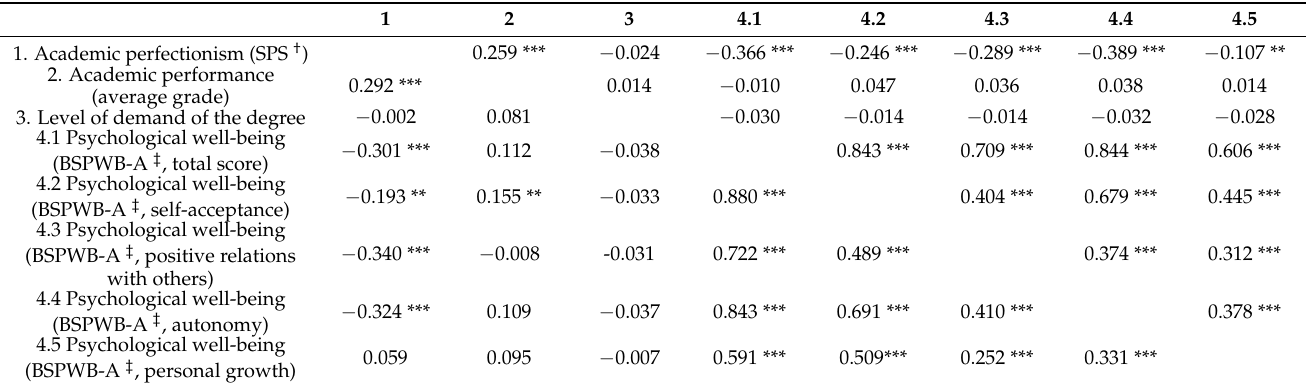
Table 1. Correlation between academic perfectionism, performance, demand, and psychological